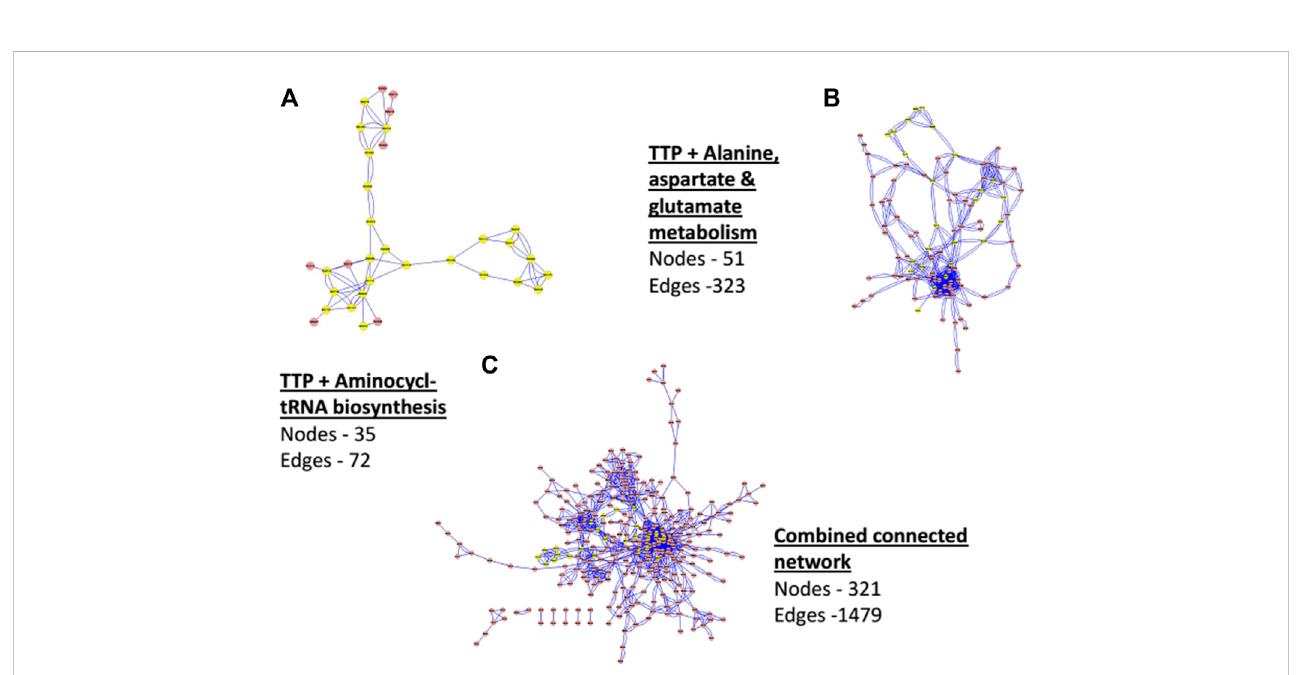
FIGURE 5 Network of TTP (with Yellow Nodes) with connected networks of (A) Aminoacyl tRNA biosynthesis pathway (map00970), (B) Alanine, Aspartate and Glutamate metabolism (map00250) and (C) Combined Connected Network